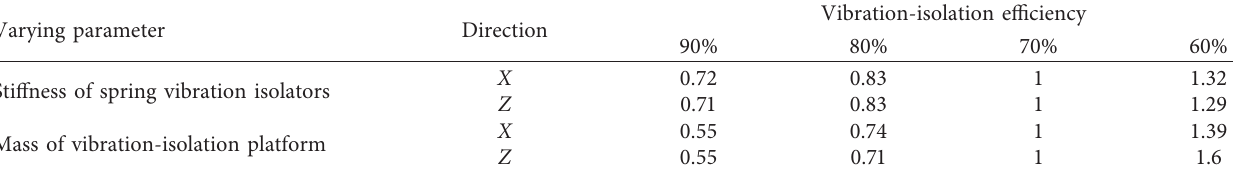
Figure 8. The maximum vibration displacements of the steel and concrete platforms are listed in Table 13.